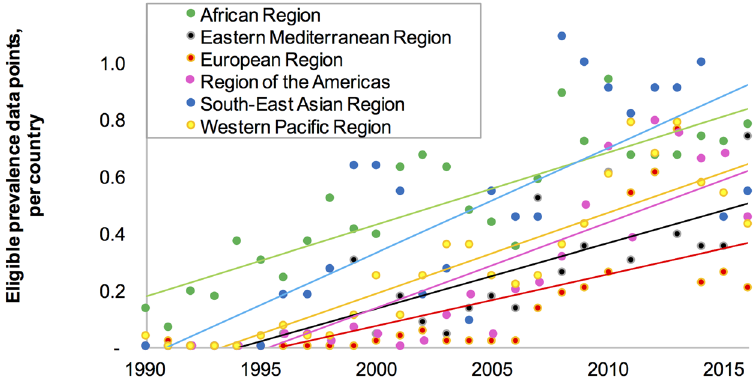
Figure 1. Average number of eligible syphilis prevalence data points, recorded in the Spectrum STI syphilis database, grouped by WHO region. Note to Fig. 1: Lines represent linear trend lines fitted through the data points for each region.